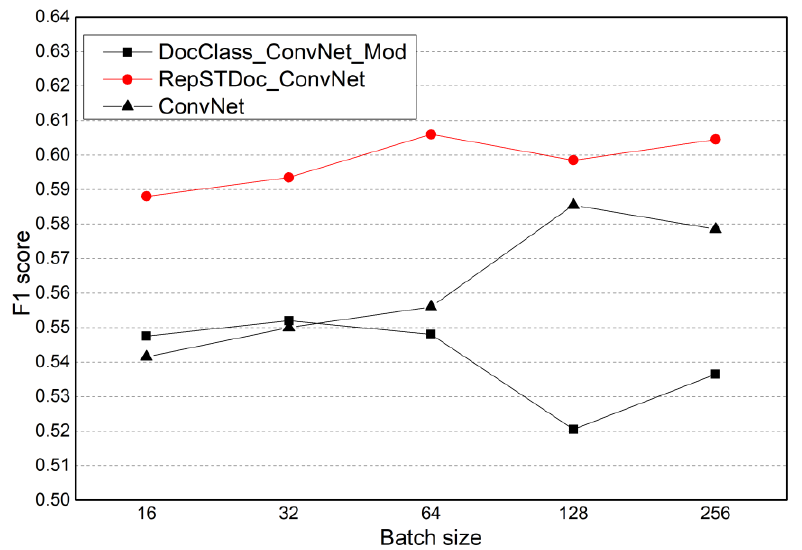
Figure 5. The effect of batch size. Table 7. The comparison of the time.